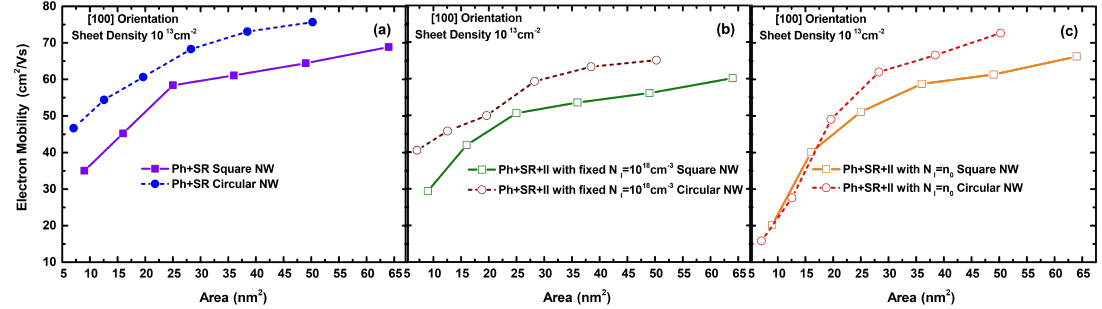
Figure 6. The electron mobility as a function of the NW cross sectional area, considering the impact of the combined total phonon and surface roughness (Ph + SR) scattering effects ( a ), as well as all present scattering mechanisms (Ph + SR + II) with a ( b ) fixed ionized impurity density ( N I = 10 18 cm − 3 ) and ( c ) the charge neutrality case. The results are for both square and circular NWs ([100] orientation) and a sheet density of 10 13 cm − 2